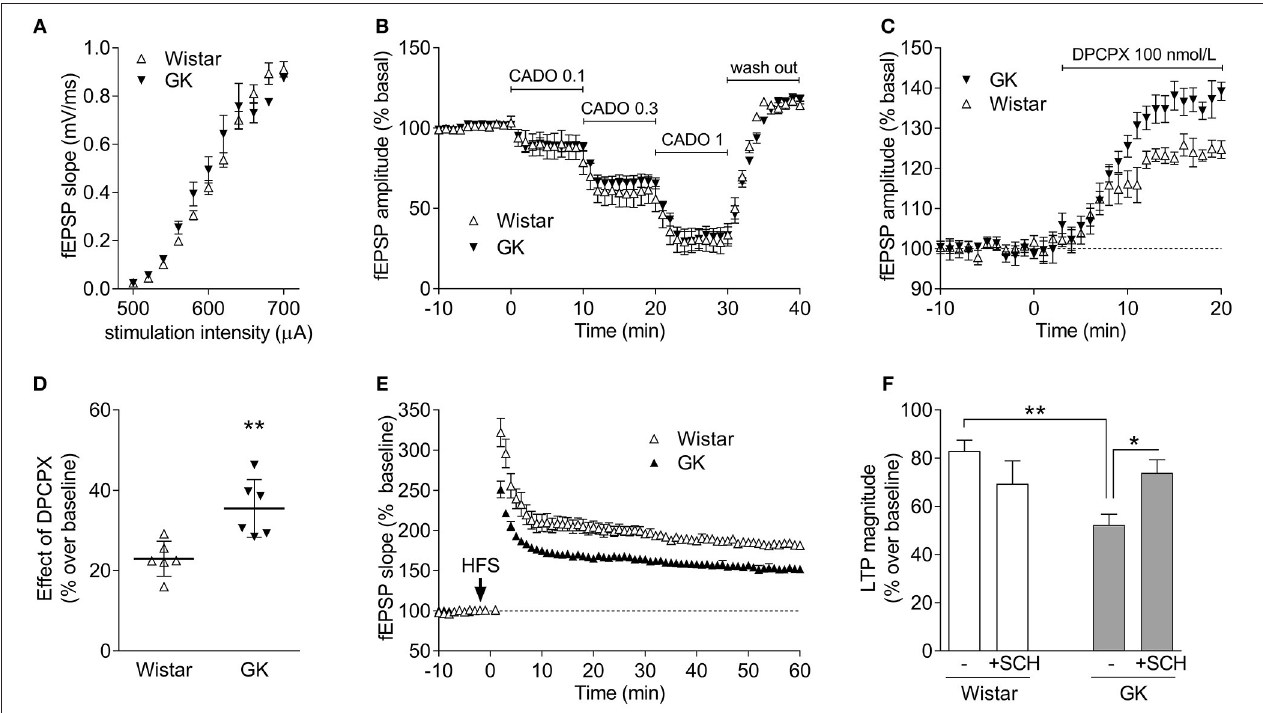
FIGURE 7 | GK rats display an unchanged A 1 R-mediated inhibition of excitatory synaptic transmission in the hippocampus but an increased A 2A R-mediated control of synaptic plasticity. (A) Superimposed input-output curves in GK (filed symbols) and Wistar rats (open symbols), indicating a similar density of excitatory innervation in Schaffer fiber-CA1 pyramid synapses of hippocampal slices. (B) Superimposable concentration-dependent curves of inhibition of CA1 hippocampal field excitatory post-synaptic potentials (fEPSPs) by the closest chemical analog of adenosine, 2-chloroadenosine (CADO; applied at concentrations of 0.1, 0.3, and 1 µ mol/L), showing that the A 1 R-mediated inhibition of synaptic transmission is similar in GK and Wistar rats. The fEPSP slope before CADO application is normalized to 100%, and 0% corresponds to a complete inhibition of fEPSPs. (C,D) GK rats seem to have higher levels of endogenous extracellular adenosine tonically activating inhibitory A 1 R, as revealed by the larger disinhibition of fEPSPs by the selective A 1 R antagonist, DPCPX. (E) Averaged time course changes of fEPSP slope induced by a high-frequency stimulation train (HFS 100Hz, 1s, applied when indicated by the arrow) in hippocampal slices taken from Wistar (open symbols) or GK rats (filed symbols), showing that the amplitude of LTP is larger in Wistar than in GK rats. (F) The presence of the A 2A R antagonist SCH58261 (50nM, + SHC), which was applied 30min before LTP induction and remained in the bath up to the end of the experiment, has a discrete effect in Wistar rats (open bars) and efficiently restores LTP amplitude back to control levels in GK rats (gray bars). The electrophysiological data are mean ± SEM of 5–6 animals per experimental condition. * P < 0.05, ** P < 0.01 using either an unpaired Student’s t test in (C) or a two-way ANOVA followed by a LSD post-hoc test in (F)